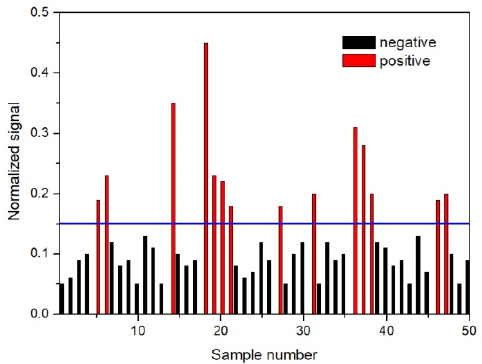
Figure 7. Results of aerobic culture bottles.